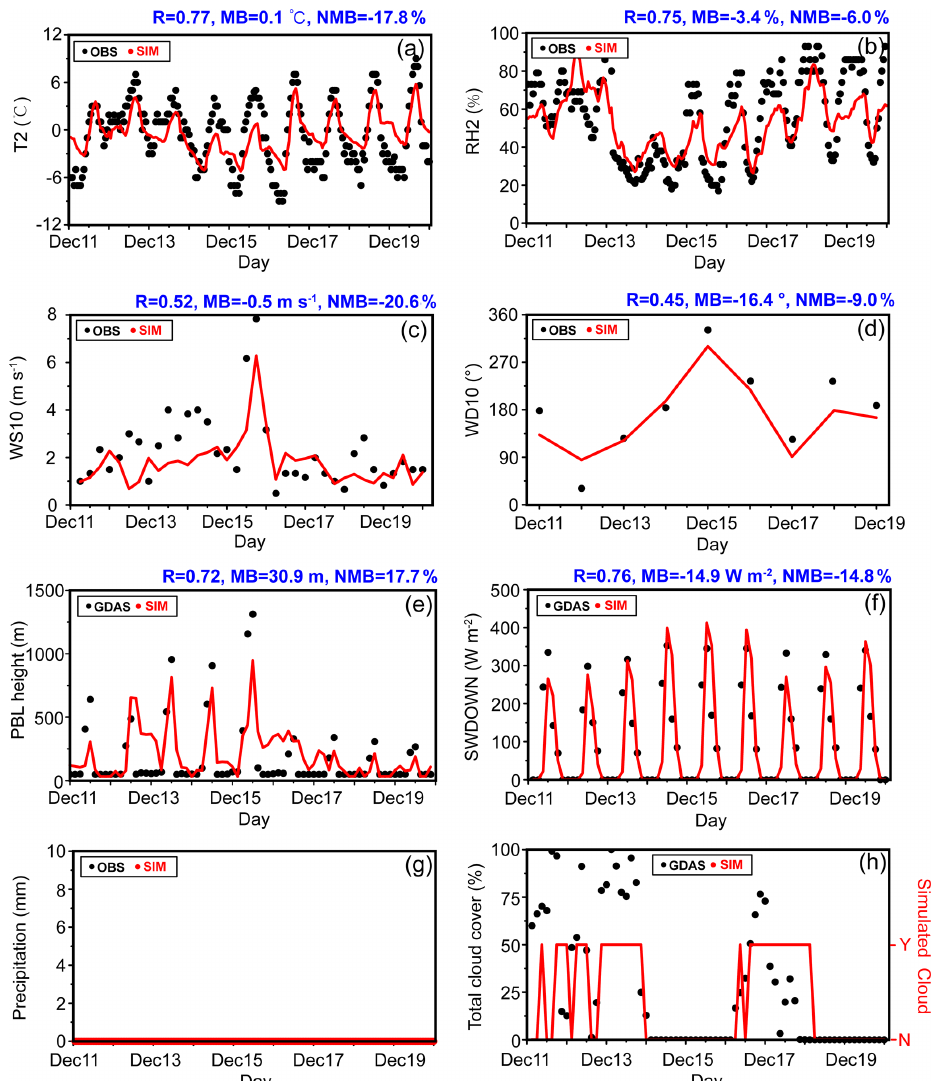
Figure 5. Comparisons of simulated meteorological parameters from CTRL simulation with measurements. The black dots and red lines are the observed (reanalysis) and simulated hourly data of T 2 ( ◦ ), RH2 (%), precipitation (mm), and 3-hourly data of PBL height (m), SWDOWN (Wm − 2 ), total cloud cover (%), 6-hourly data of WS10 (ms − 1 ), and daily data of WD10 ( ◦ ) in Beijing from 11 to 19 December 2016. PBLH, SWDOWN, and total cloud cover are taken from GDAS. The WRF-Chem model output shows only whether a grid has cloud (Y) or no cloud